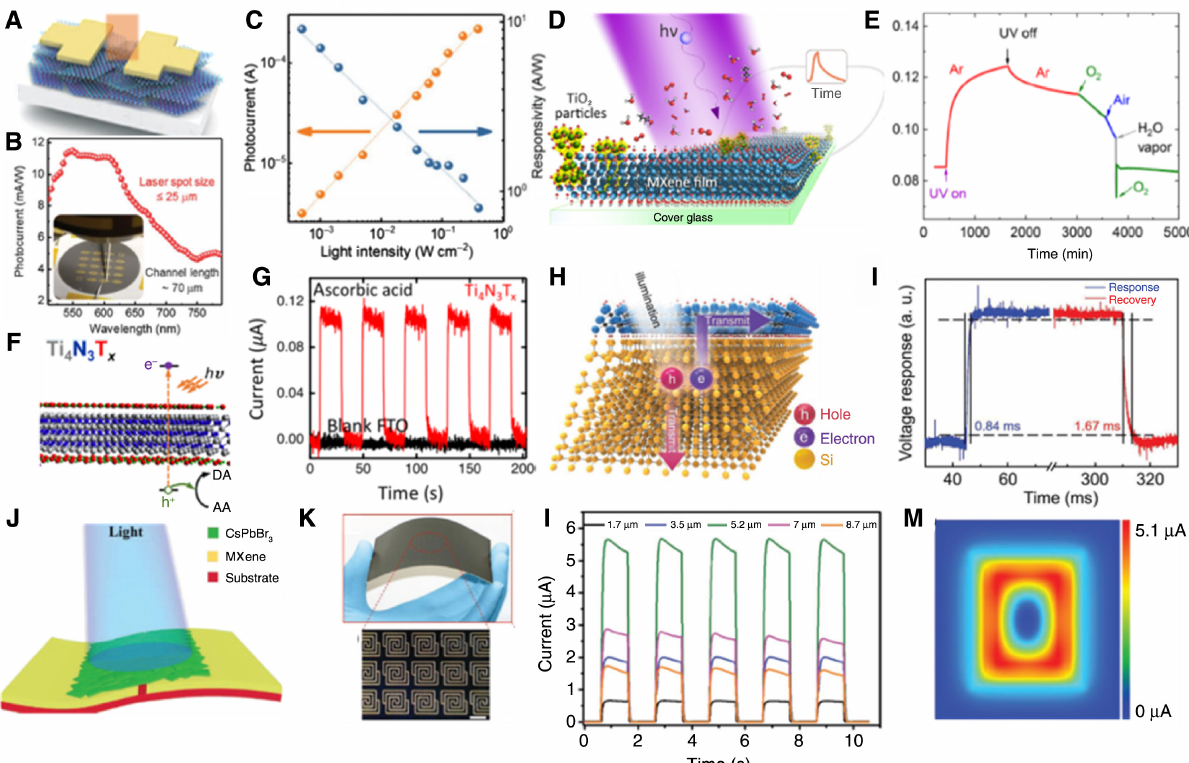
Figure 8: MXene applications for photodetectors. (A) Schematic of two-terminal photodetector based on Mo photodetector under a bias voltage of 0.7 V. Inset depicts photograph of setup of photocurrent measurement based on an array of two- terminal Mo CT photodetectors. (C) Photocurrent and responsivity of Mo 2 x intensity. (D) Schematic of partially oxidized Ti